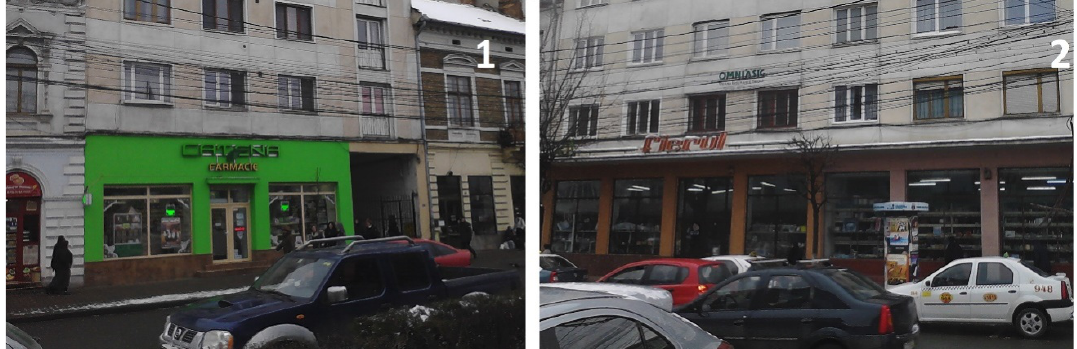
Figure 22: Residential buildings with low wealth commercial activities on the ground floor in Mihai Viteazul Square. 1 – unaesthetic refurbished façade; 2 – industrial, and chemical products shops with the Communist commercial logo intact Source: Zoltan MAROȘI,